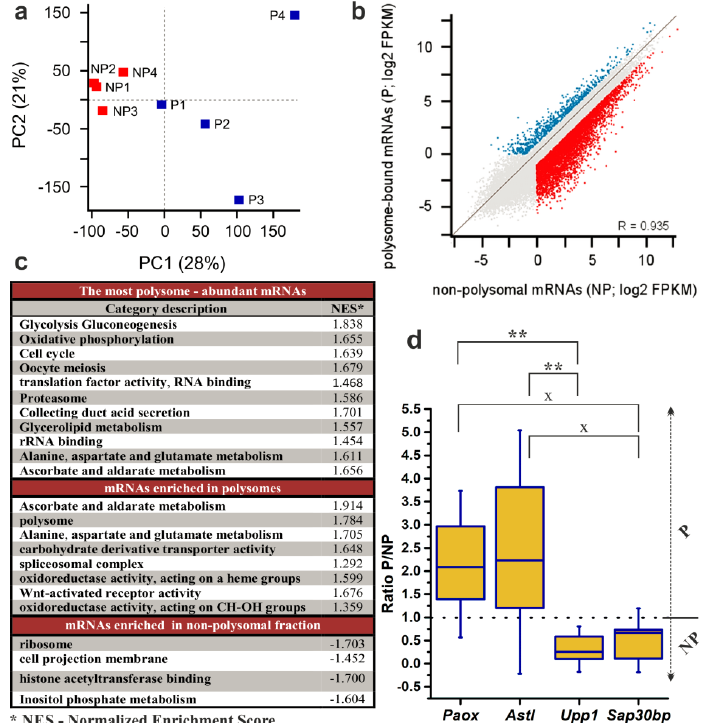
Figure 4. Analysis of RNA-seq results of 200 NEBD-stage oocytes. Non-polysomal (NP) and polysomal (P) RNAs were sequenced in four biological replicates. ( a ) Principal Component Analysis was applied to demonstrate variability among biological replicates. ( b ) Scatter plot highlighting genes with FPKM > 1 (fragments per kilobase per million reads mapped > 1) and > 2-fold enrichment in the NP (blue) and in the P (red). ( c ) Enriched gene categories according to GO (Gene Ontology) and KEGG (Kyoto Encyclopedia of Genes and Genomes) terms in dataset of all expressed genes with cut-off score of FPKM > 1. ( d ) qRT-PCR determination of the P/NP ratio for selected transcripts in three additional biological replicates. Box plot displays mean, 25th and 75th percentile and ±SD; dotted line indicates no fold change; ** p < 0.01; x signifies a lack of significance; Dunn´s multiple comparison is displayed only for pairs of transcripts that have been originally selected to be preferentially enriched in either the P or the NP dataset according to